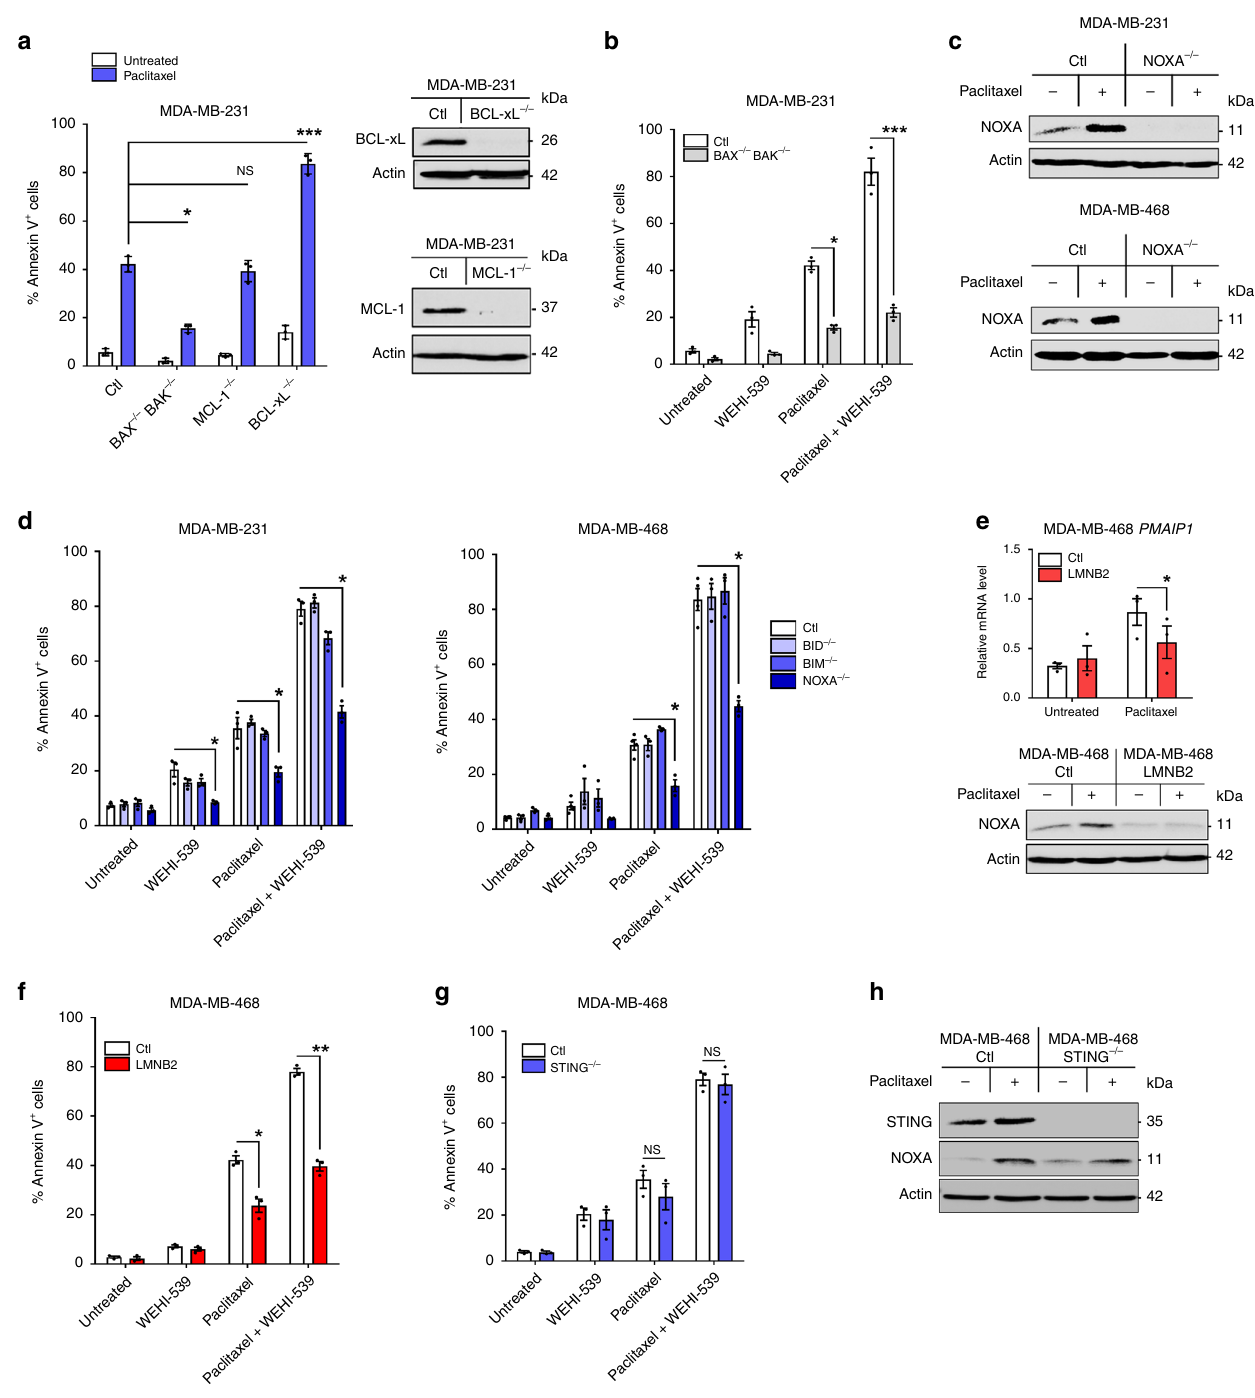
Fig. 6 NOXA is induced by micronuclei envelope collapse-dependent but STING-independent signals. a Annexin V assay in control, BCL-xL or MCL-1 KO MDA-MB-231 cells treated or not with paclitaxel for 24 h, washed out, incubated for 48 h (left panel). Analysis of BCL-xL and MCL-1 expression in untreated cells was realized by immunoblot (right panel). b Same analysis as in a in control or double KO BAX − / − BAK − / − MDA-MB-231 cells treated with paclitaxel for 24 h or not, washed out for 48 h then treated with WEHI-539 for 24 h or not ( c ). Immunoblot analysis in control or NOXA − / − breast cancer cells 48 h after a 24 h-paclitaxel treatment. d Same experiment as ( b ) using control, BID − / − , BIM − / − , or NOXA − / − MDA-MB-231 or MDA-MB-468 cell lines. e PMAIP1 qPCR (upper panel) and NOXA immunoblot (lower panel) in control or LMNB2 overexpressing MDA-MB-468 cells 48 h after a 24 h- paclitaxel treatment. f Same experiment as ( b ) using control or LMNB2 overexpressing MDA-MB-468 cells. g Same experiment as ( b ) using control or STING − / − MDA-MB-468 cells and indicated treatments. h NOXA immunoblot analysis in control and STING − / − MDA-MB-468 cells harvested 48 h after a 24 h-paclitaxel treatment. Data were collected from n = 3 independent experiments. Error bars indicate mean + / − SEM; Two-sided paired t -test. The symbols correspond to a p -value inferior to *0.05, **0.01, and ***0.001. NS: not signi fi